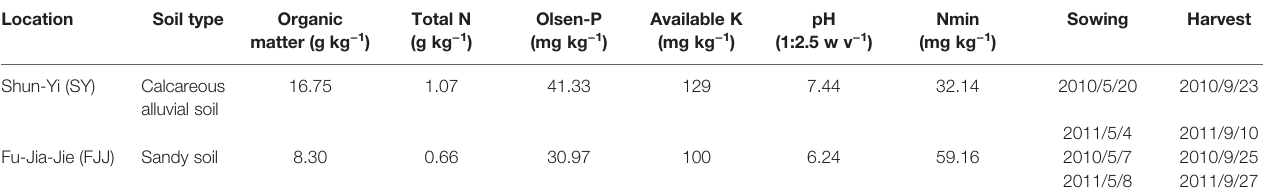
TABLE 2 | Properties of soils in the fi eld used for the experiments at Shun-Yi (SY) and Fu-Jia-Jie (FJJ).